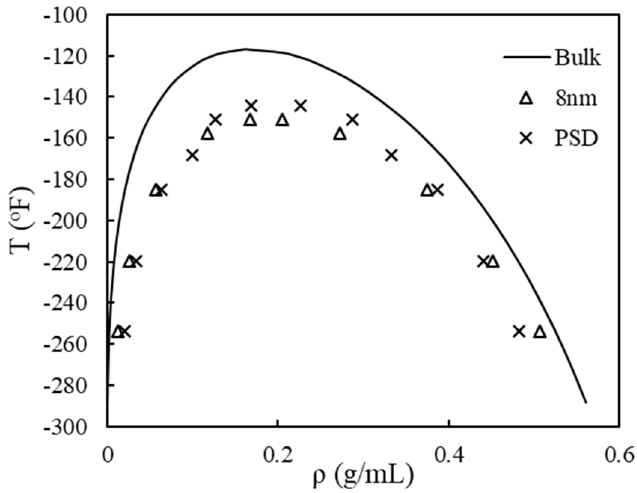
Figure 7. Simulated coexistence curves of methane with pore size distribution and in an 8 nm single capillary tube. PSD represents pore size distribution.